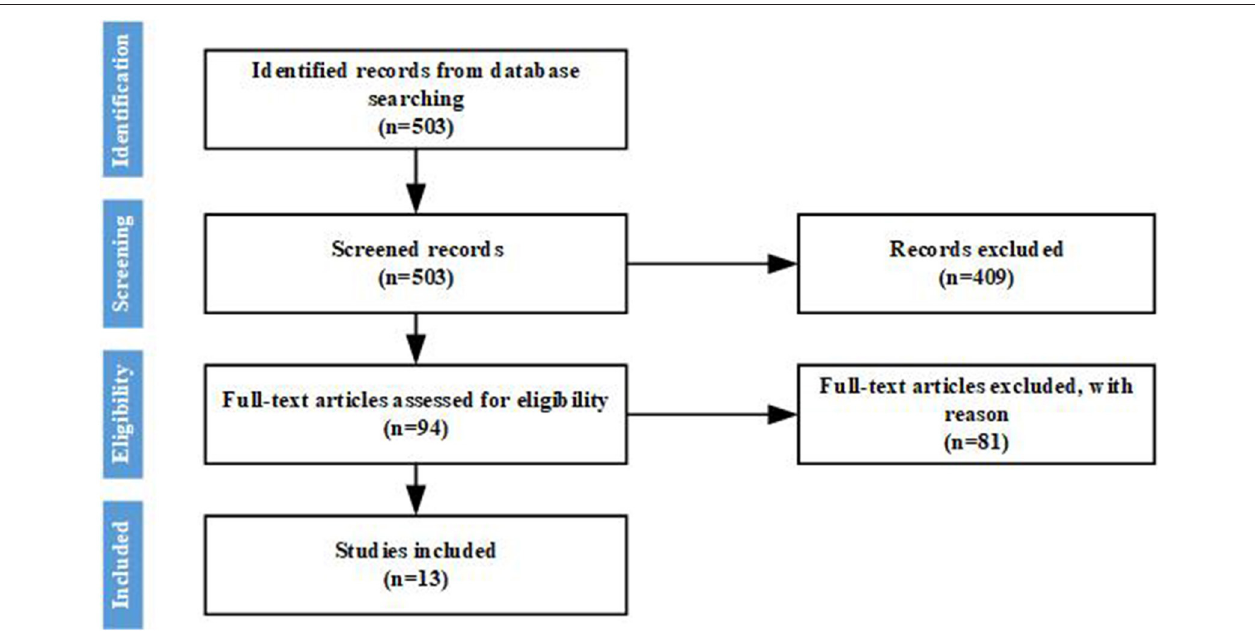
FIGURE 1 | Flow chart of the study selection process.